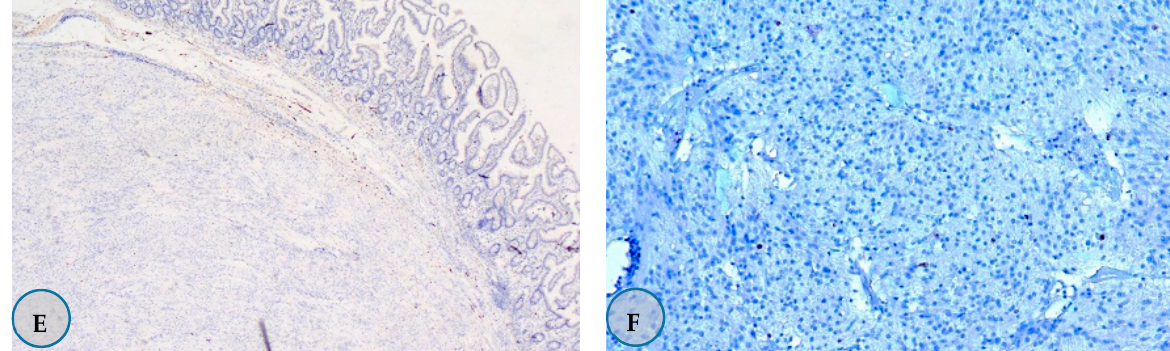
Figure 1. Immunohistochemistry staining samples in Gastrointestinal stromal tumor. ( A ) 85% positive staining with the C Kit ×40. ( B ) CD ‐ 34 showed more than 50% positive staining for ×200. ( C ) ‐ SMA ‐ negative staining in tumor, positive staining in vascular walls and muscularis mucosa ×40. ( D ) Positive staining with desmin ×40. ( E ) ‐ Negative staining with S ‐ 100 ×40. ( F ) 2% staining with Ki ‐ 67 ×200.